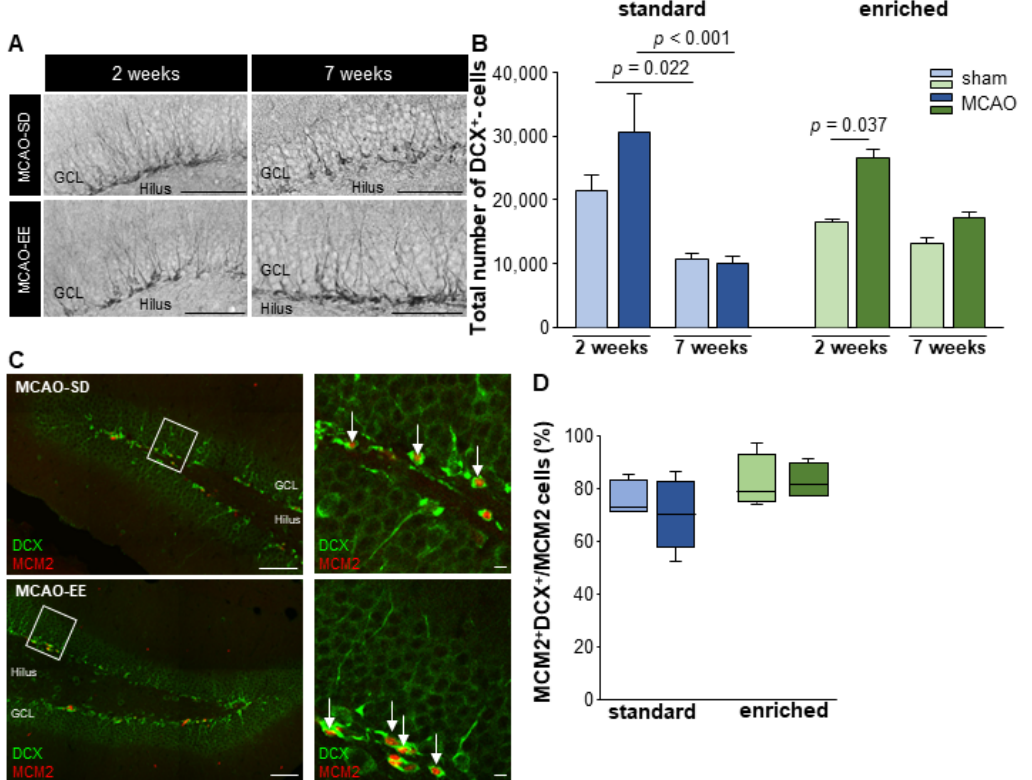
Figure 4. Impact of stroke and EE on DCX + cell proliferation. ( A ) Peroxidase-stained brain slices for DCX 2 and 7 weeks after stroke. ( B ) Quantification of DCX + cells in the dentate gyrus. The absolute number of DCX + cells significantly decreased after stroke in the standard but not in the EE groups. Statistical analysis was performed using the ANOVA and post-hoc Bonferroni, MW ± SEM; scale bar = 100 µ m. ( C ) Exemplary immunofluorescence staining for MCM2 (red) and DCX (green) after MCAO in standard and EE housing groups. ( D ) Percentage of proliferating DCX + cells from all proliferating cells in the dentate gyrus. Statistical analysis was performed using the Mann–Whitney U test, scale bar = 100 µ m, higher magnification 10 µ